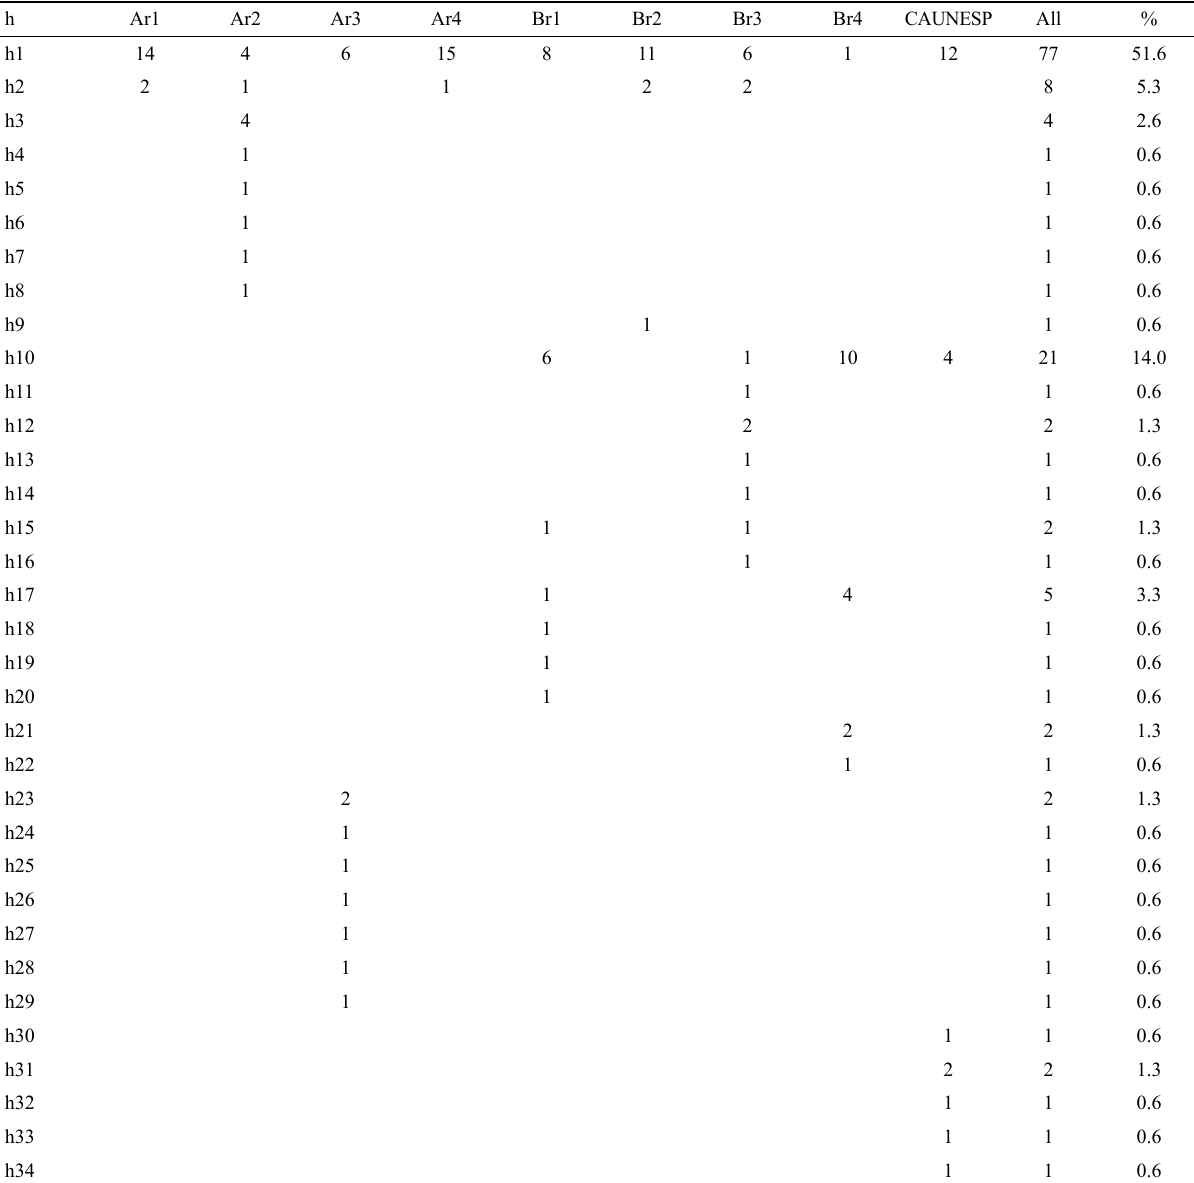
Table 2 - mtDNA haplotypes distribution among fish farms (Ar and Br) and the breeding nucleus (CAUNESP).